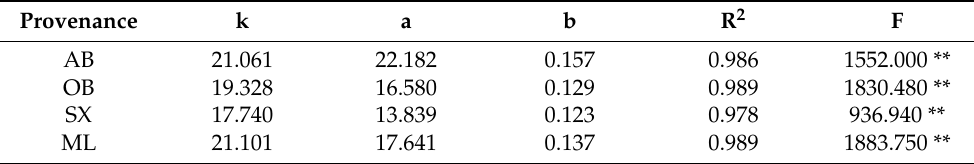
Table 8. Estimated parameters of logistic curve of seedling height of X. sorbifolium from differ- ent provenances.